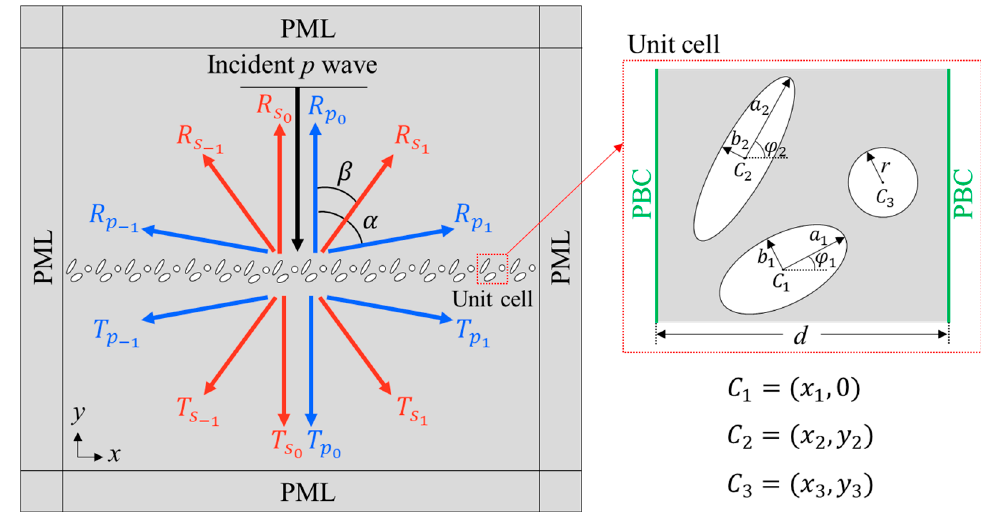
Figure 1. Physical configuration of the elastic metagratings, where six longitudinal (blue arrows) and six transverse (red arrows) diffraction channels are schematically shown. Each unit-cell consists of two elliptical and one circular hollow cylinders curved in a steel background, as shown in the inset with corresponding geometrical parameters